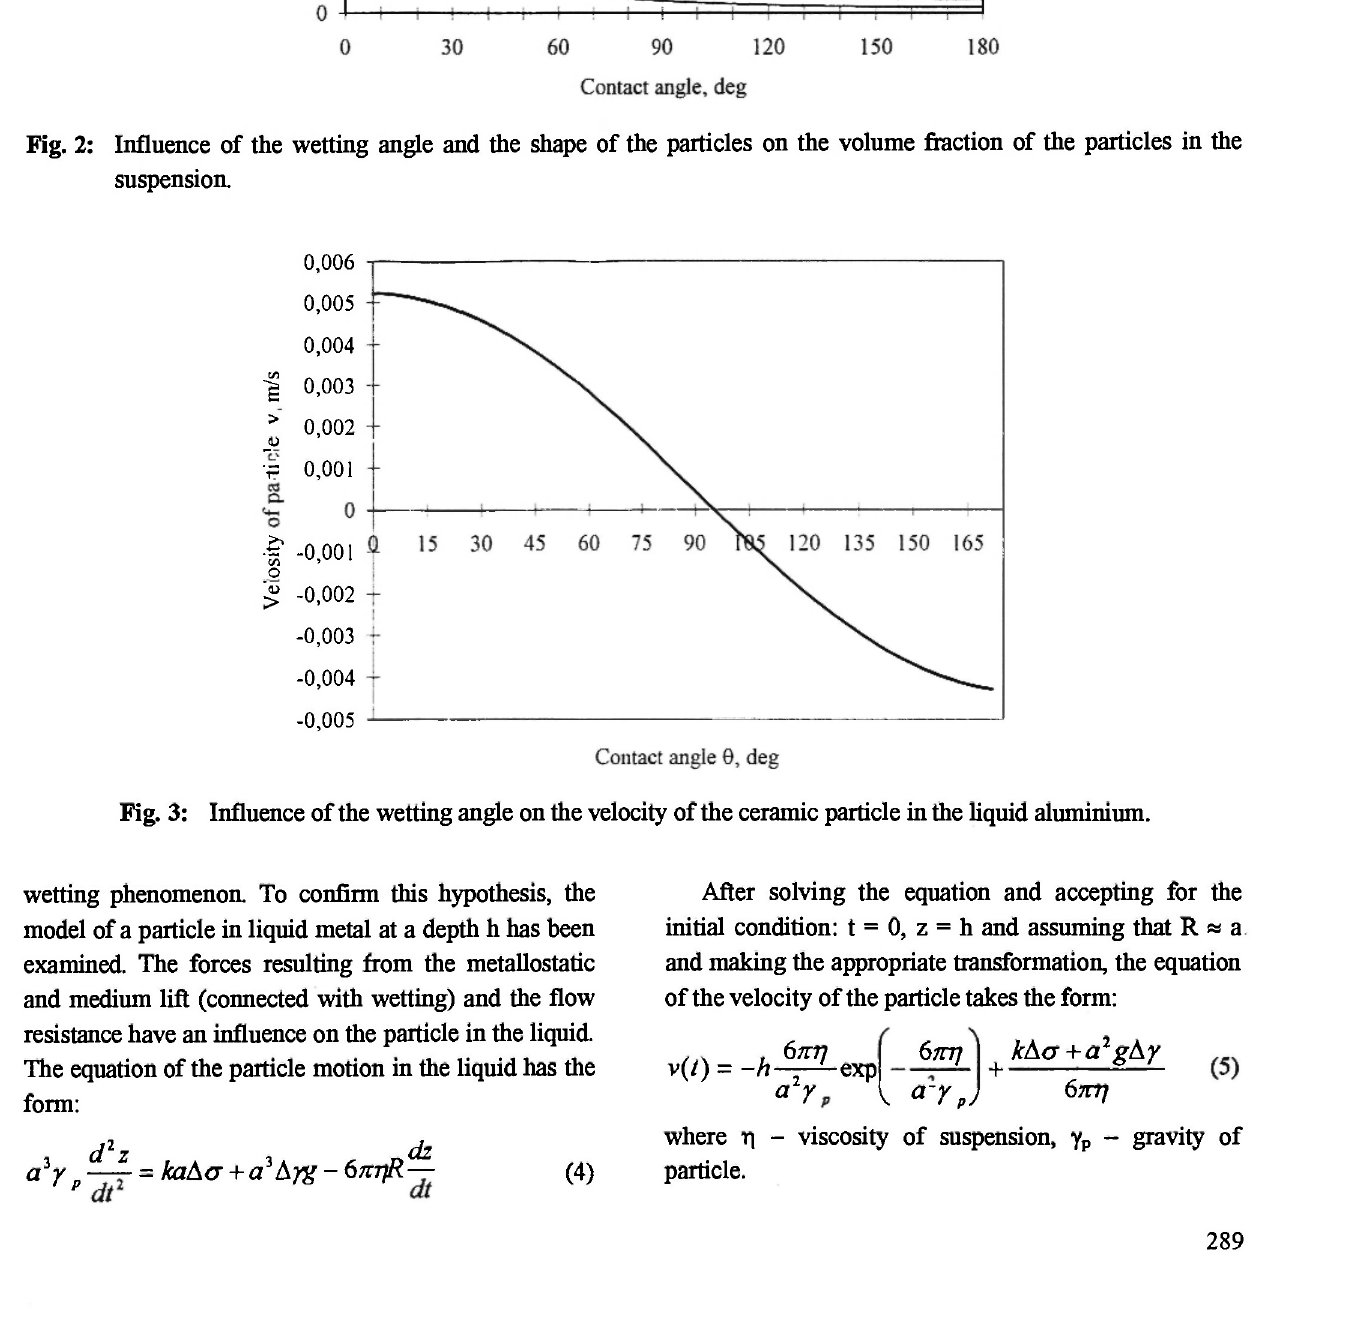
Fig. 2: Influence of the wetting angle and the shape of the particles on the volume fraction of the particles in the suspension.